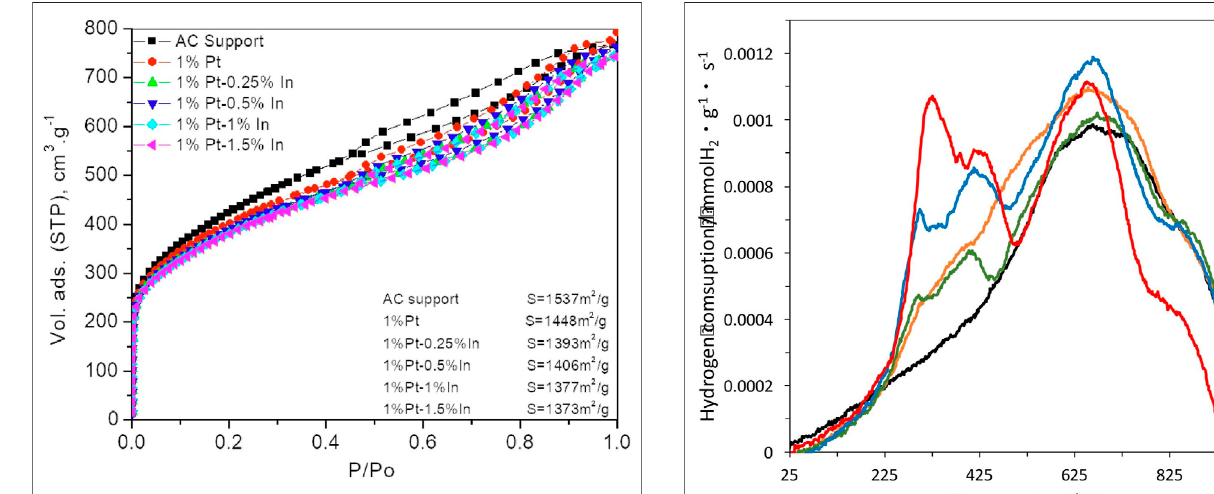
FIGURE 1 | N 2 adsorption isotherms of the different samples.